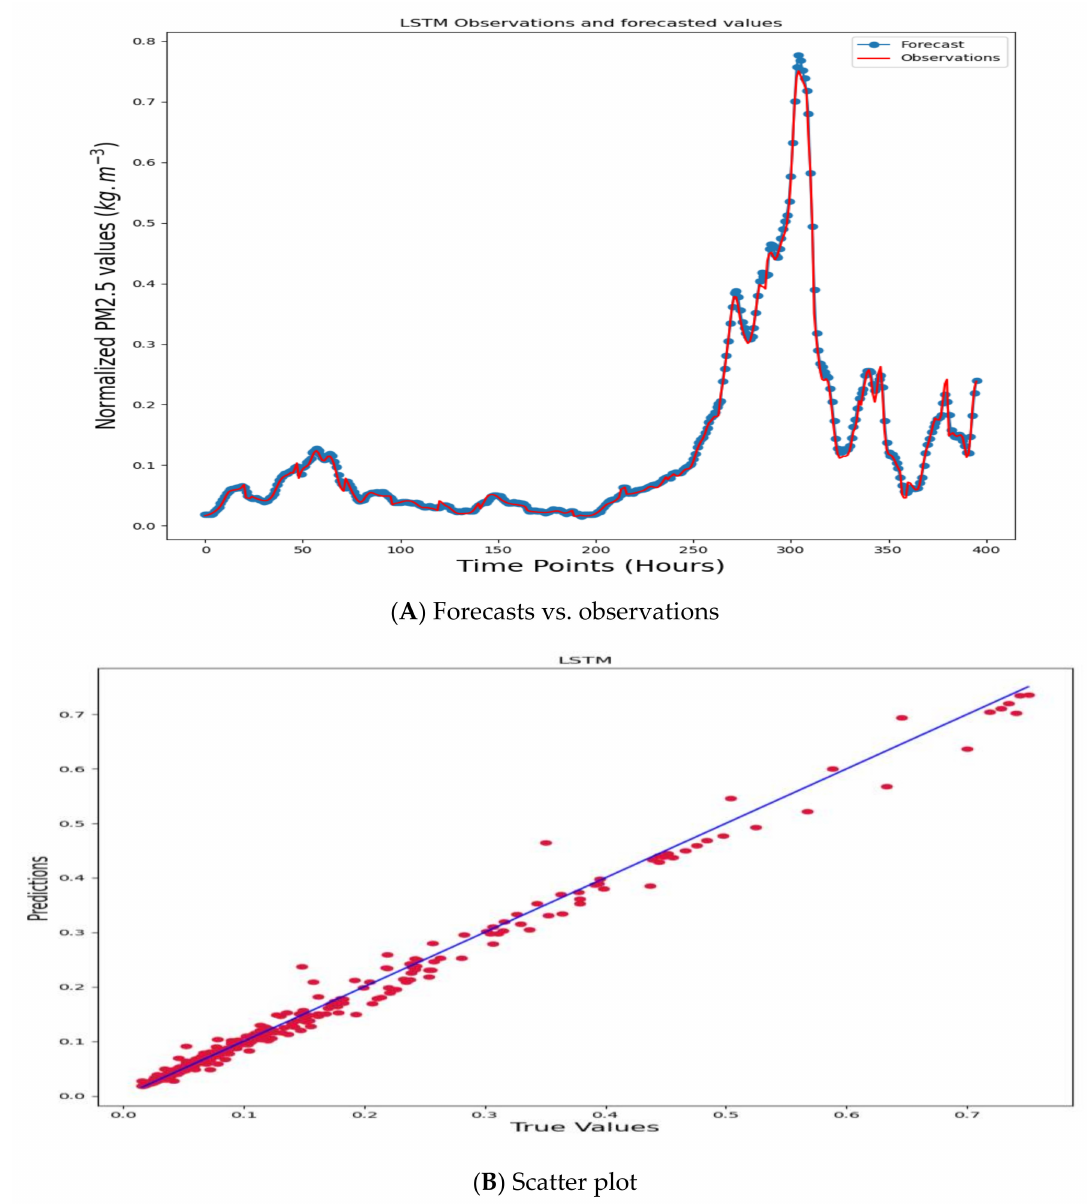
Figure 4. Forecasting results of